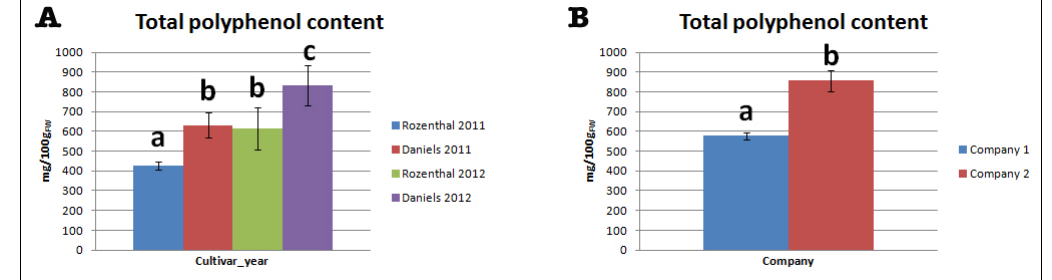
Fig. 2: Ribes nigrum : TPC in University bud-preparations (A) and Company bud- preparations (B). Different letters for each sample indicate the significant differences at P<0.05.